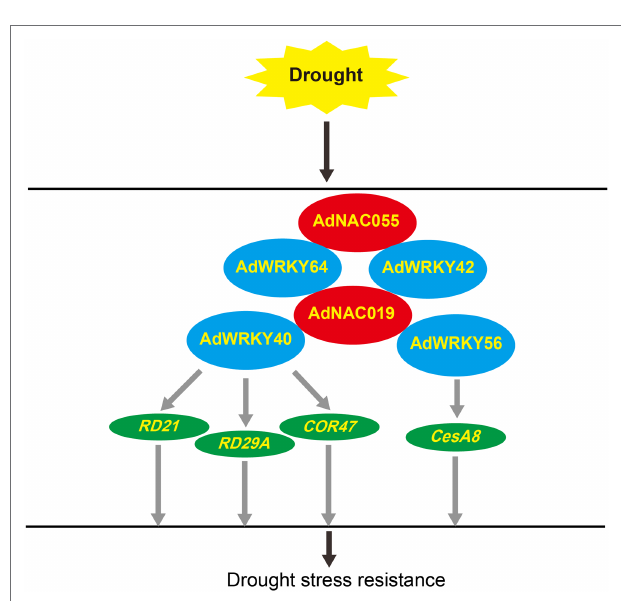
FIGURE 8 | AdWRKYs regulatory networks under drought stress. The gray arrow indicates hypothesis but no experimental